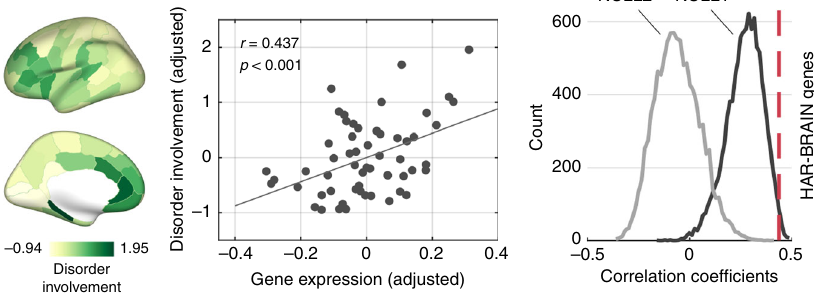
Fig. 5 Cortical disorder involvement and HAR-BRAIN gene expression. Left panel shows brain maps of cortical involvement across fi ve major psychiatric disorders (e.g., schizophrenia, bipolar disorder, autism spectrum disorder, major depression, and obsessive-compulsive disorder). Middle panel shows correlation between HAR-BRAIN gene expression and disorder involvement (Pearson ’ s r = 0.437, p < 0.001; corrected for cortical volume), and right panel shows the comparison of the correlation coef fi cient to null distributions generated by random BRAIN (NULL1; p = 0.022) and ECE genes (NULL2; p < 0.001, permutation test, 10,000 permutations). Source data provided as Source Data Strati fi ed LDSC analysis 29 did not result in fi ndings of